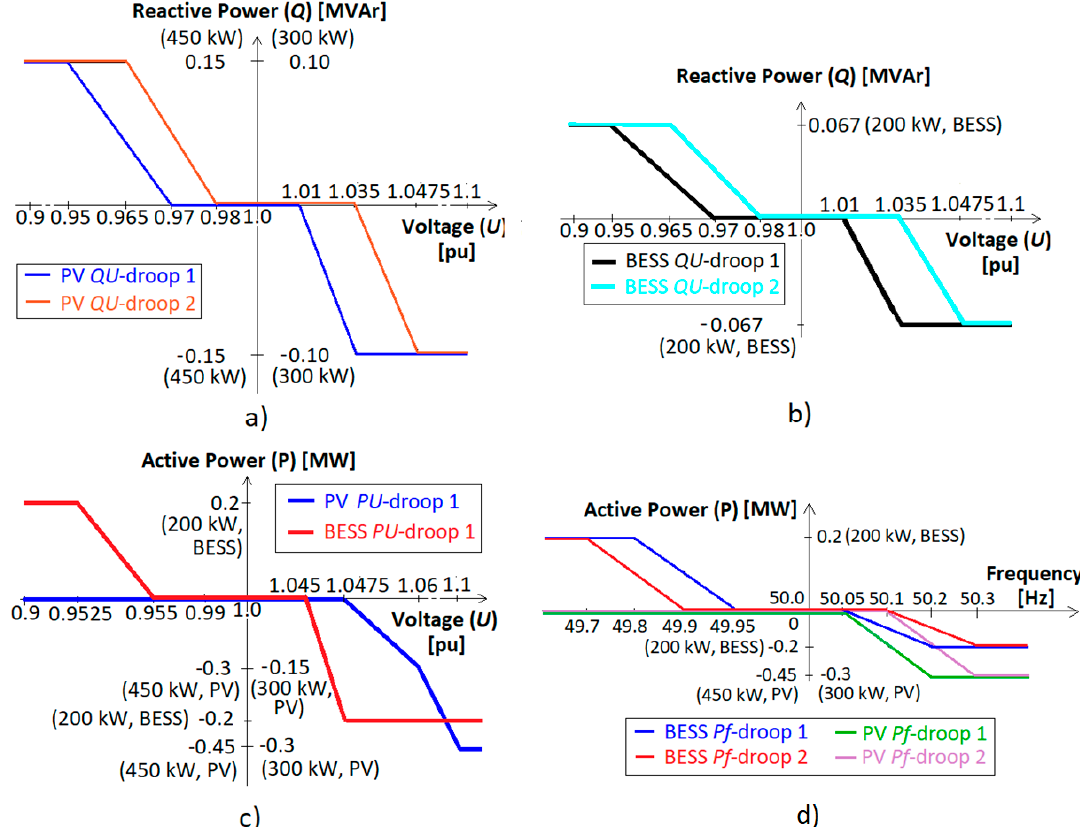
Figure 2. ( a ) QU -droop settings of PV units, ( b ) QU -droop settings of BESS units, ( c ) PU -droop settings of PV and BESS units, and ( d ) Pf -droop settings of BESS units which were used in the PSCAD simulations (see also Figures 1 and 3).